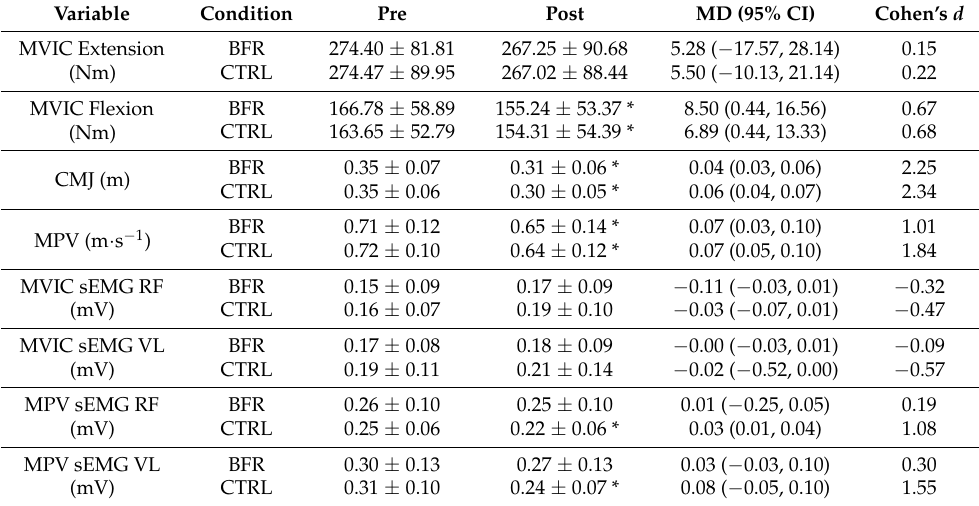
Table 3. Pre- and Post-Resistance Exercise Fatigue